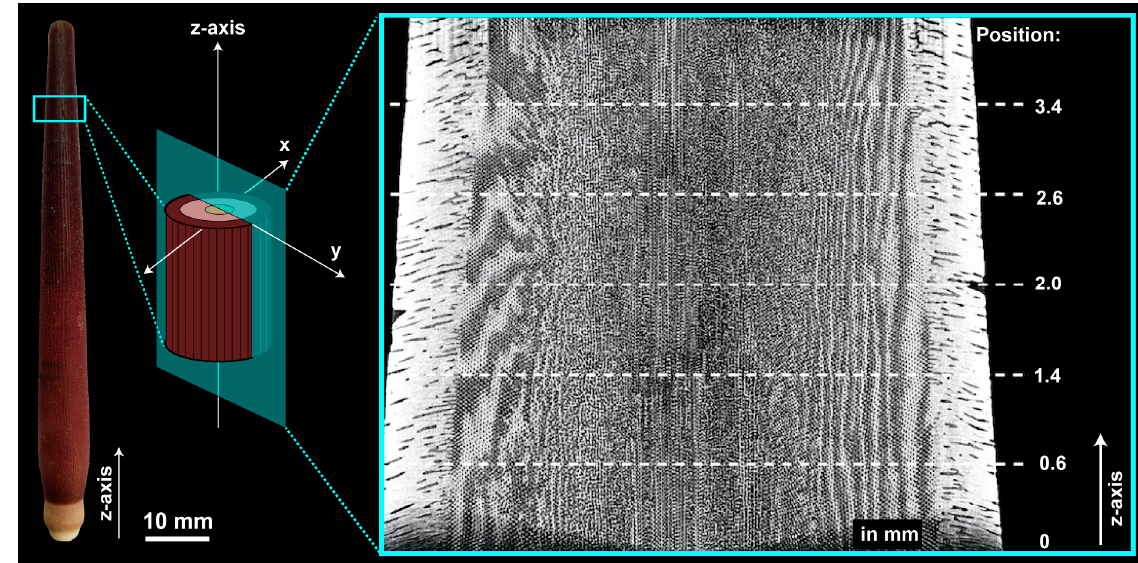
Figure 4. Spine of Phyllacanthus imperialis . Turquoise box illustrates the scanned area via µCT. A complete reconstruction of the scanned spine area can be seen on the right-hand side.